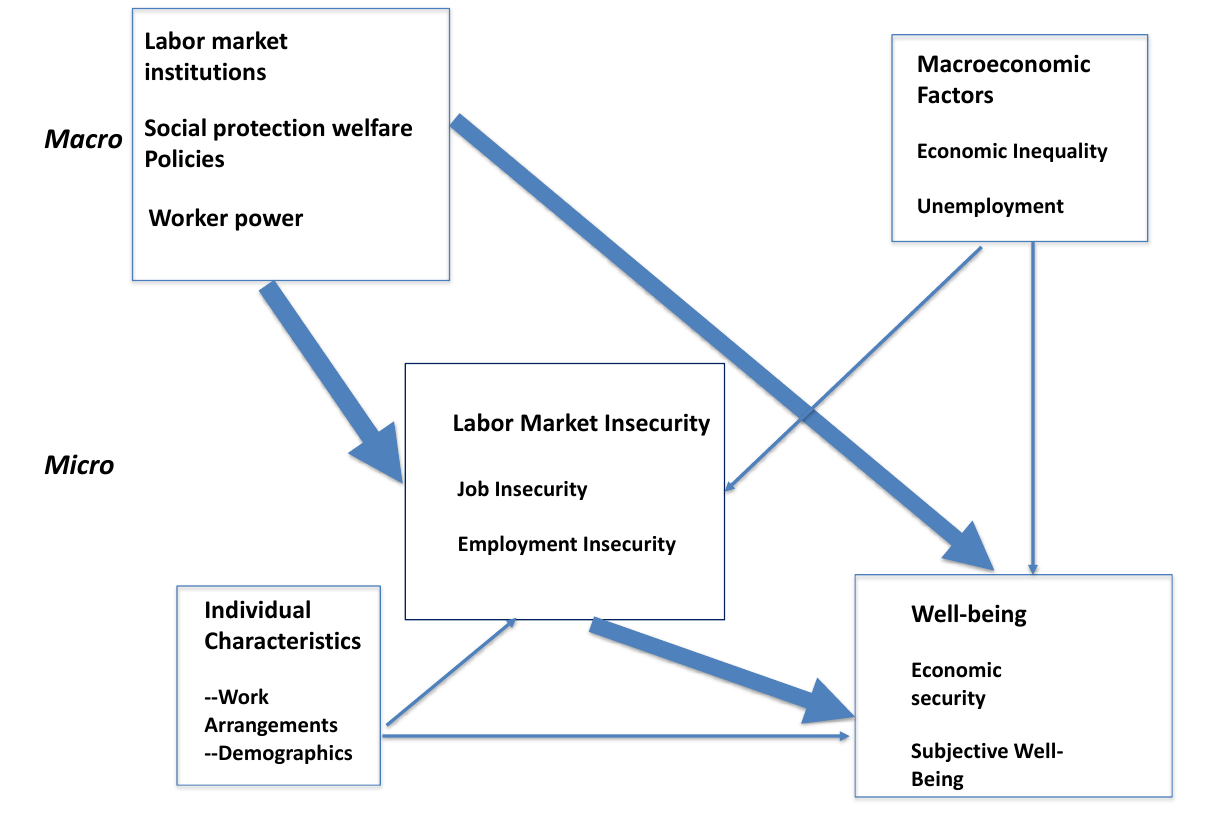
Figure 1. Multi-level conceptual model.